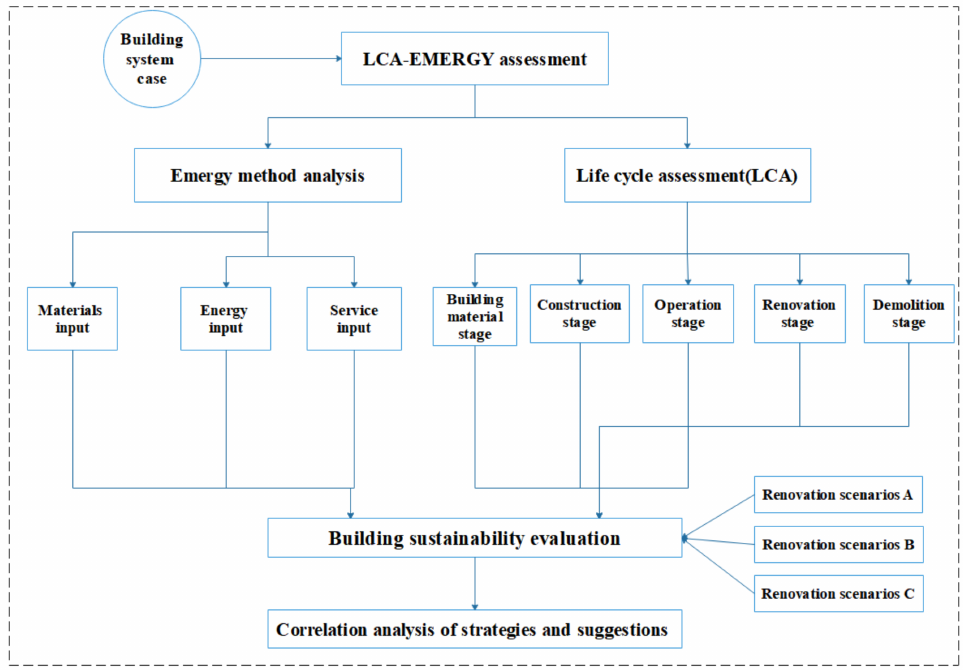
Figure 1. LCA-Emergy research